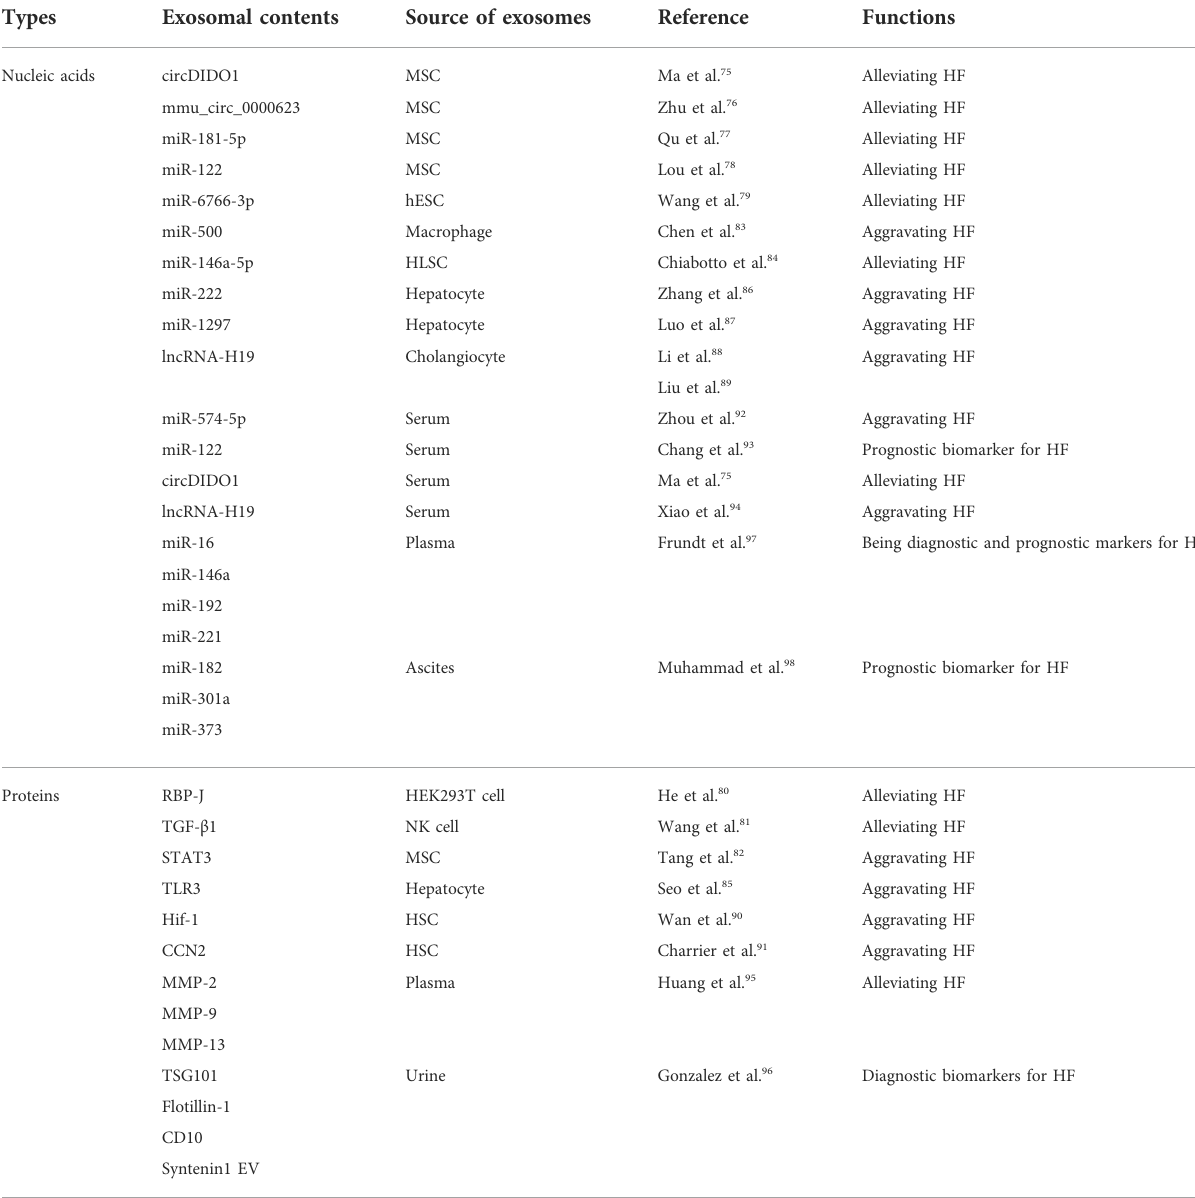
TABLE 3 Function of nucleic acids and proteins carried by exosomes on hepatic fi